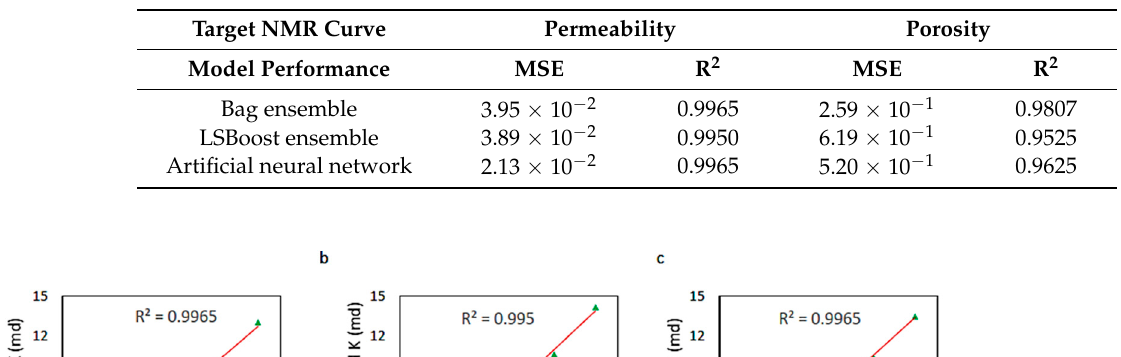
Table 11. Performance of the employed algorithms in estimating petrophysical properties from the post-stack seismic data.